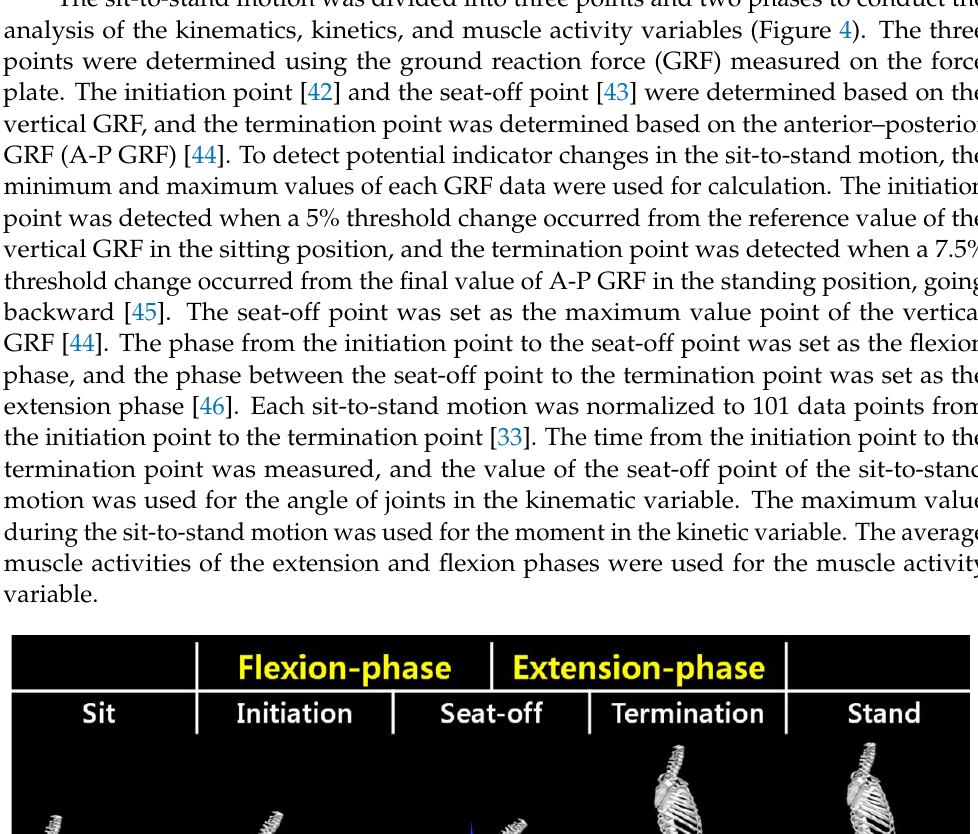
Figure 3. Attachment of EMG electrodes.